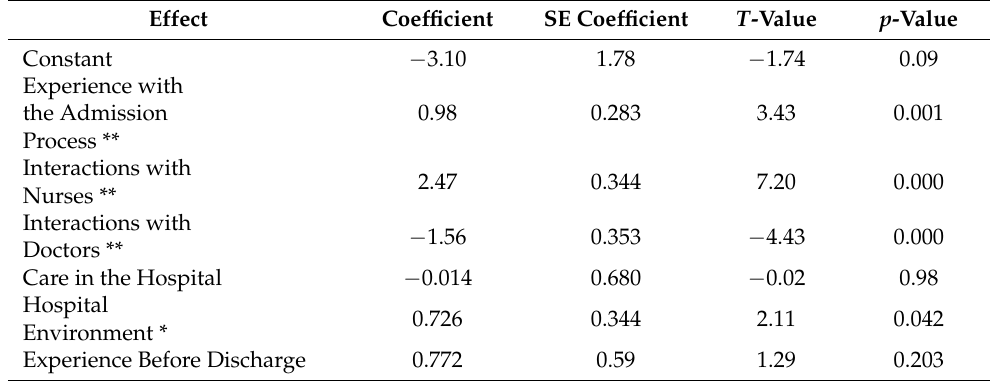
Table 4. Multiple linear regression analysis between the child respondents and their overall